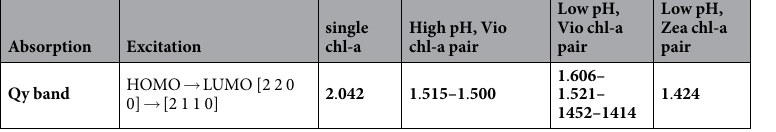
Table 2. Vertical excitation energies ( Qy band ) of an isolated Chl-a and the chl-613/614 pigment pair ground state (in eV) at different lumen states in the presence of Violaxanthin (Vio), or Zeaxanthin